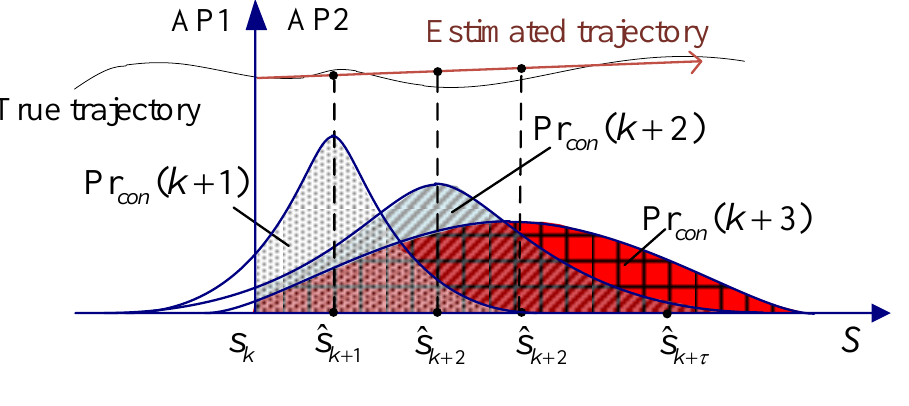
Figure 4. Confidence probability